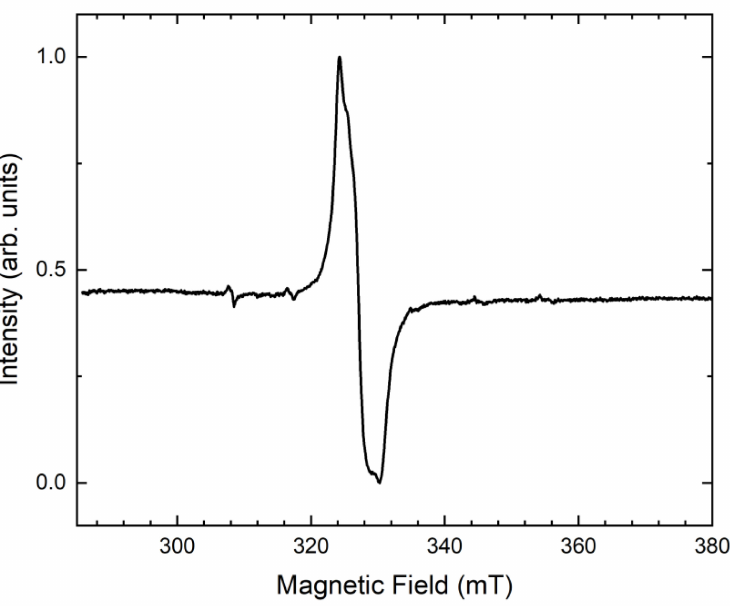
Figure 20. The ESR spectrum of vladimirivanovite (Sample